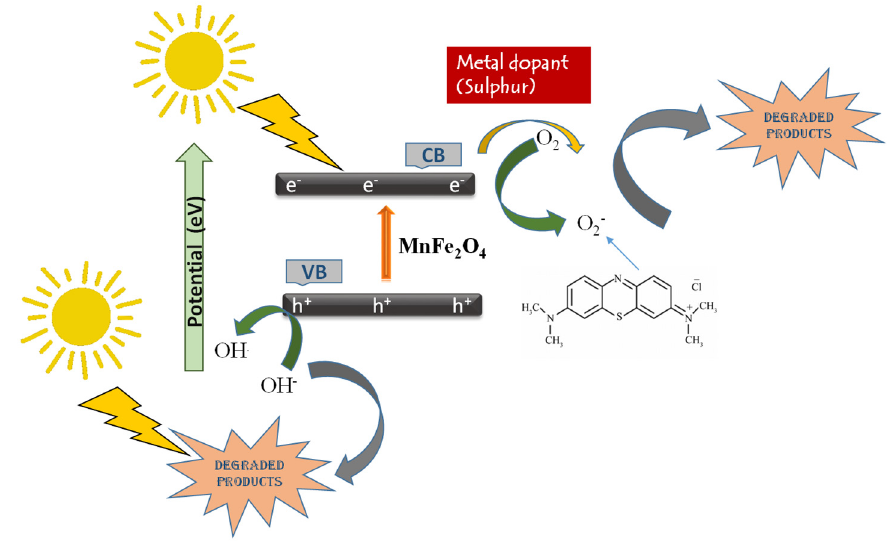
Figure 10. Mechanism of the photocatalytic activity of manganese ferrite in the presence of sunlight.